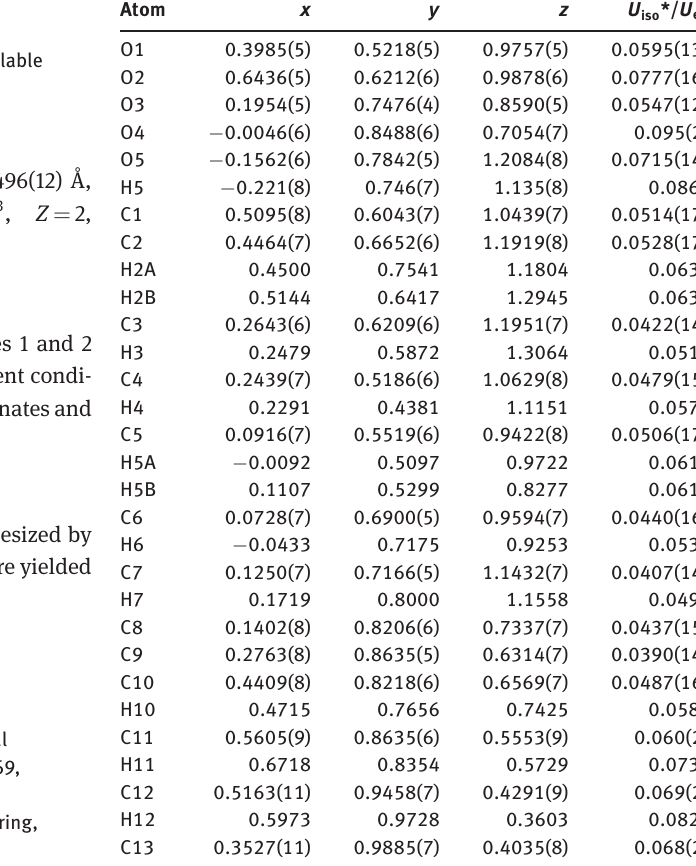
Table 2: Fractional atomic coordinates and isotropic or equivalent isotropic displacement parameters (Å 2